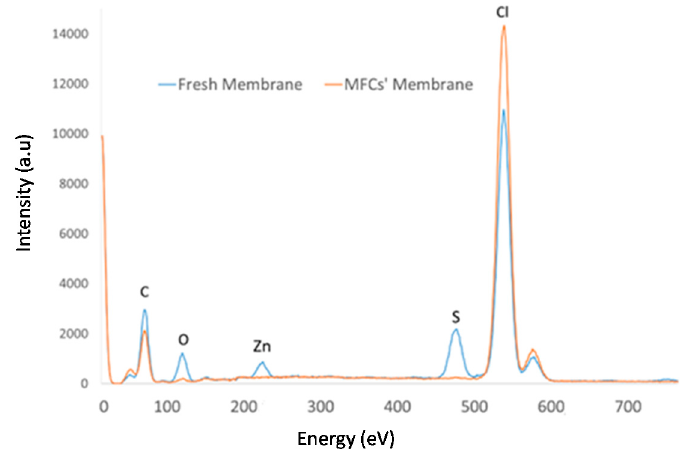
Figure 3. Energy dispersive X-ray (EDX)spectra of the [MTOA + ][Cl − ] (70% w / w ) membrane, fresh and after operation in MFCs with white oil refinery wastewater. Table 2. EDX spectrum data of membranes before and after use in MFCs in contact with oil industry wastewater.